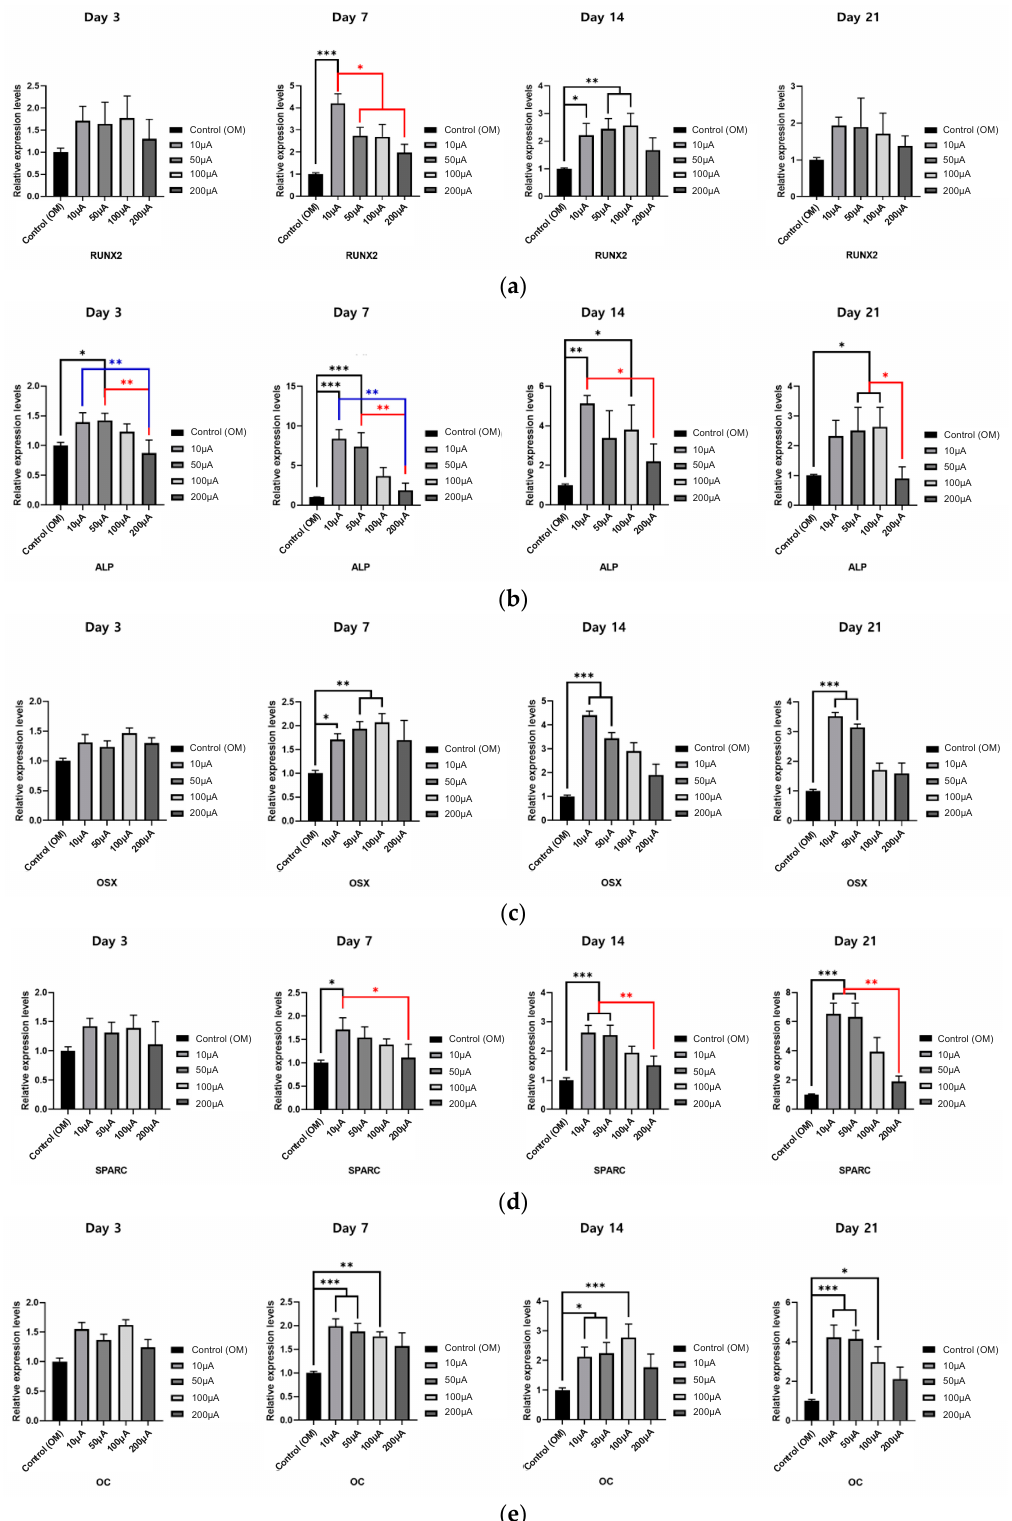
Figure 5. ( a–e ) The expression of five osteogenesis-related genes ( RUNX2 , ALP , OSX , SPARC , OC ) in cells grown on O 2 plasma-treated ITO glass with electrical stimulation (one-way ANOVA, Tukey’s HSD post-hoc test was performed, and error bars represent the standard deviation (SD), * p < 0.05, ** p < 0.01, *** p < 0.001). In all graphs, different line colors (red, blue, black lines) were used to show clear